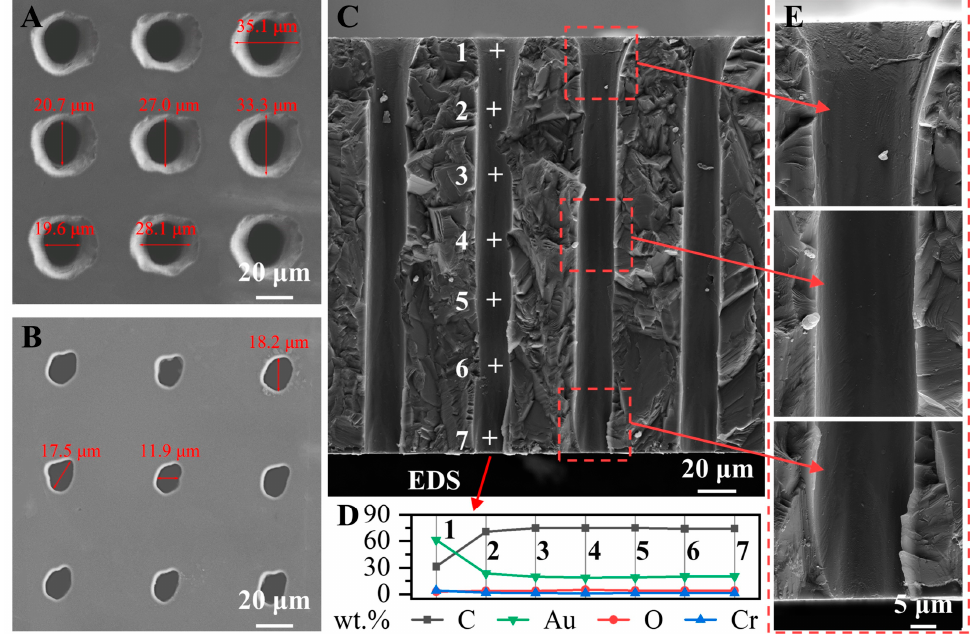
Figure 2. ( A ) Front and ( B ) rear surface SEM images of the TDV. ( C ) Cross-sectional SEM image of TDV. ( D ) EDS points of the vias in ( C ). ( E ) Partial enlargement of ( C ). The EDS elemental distribution at different points in Figure 2C is described in Figure